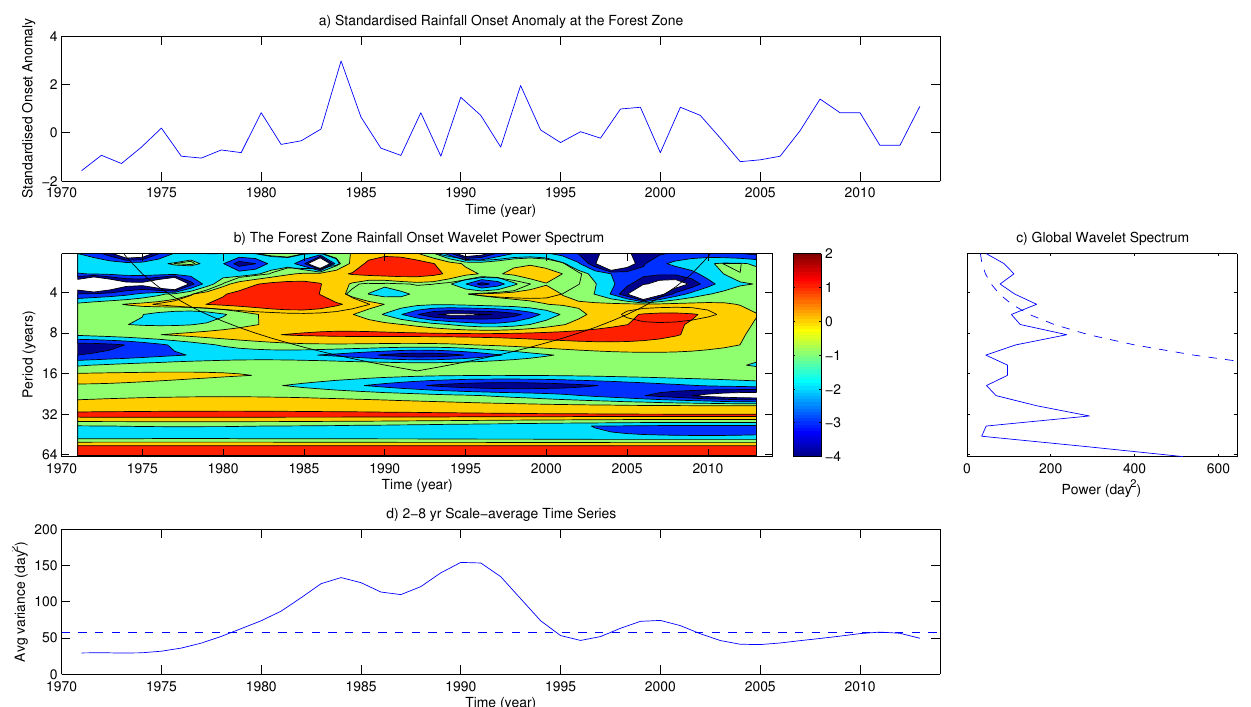
Figure 10. Interannual variability of rainfall onset dates for the forest zone using wavelet analysis. ( a ) Standardized anomaly of onset; ( b ) as in Figure 6; ( c ) the same as in Figure 6; ( d ) as in Figure 6; the dashed line shows the 95% confidence